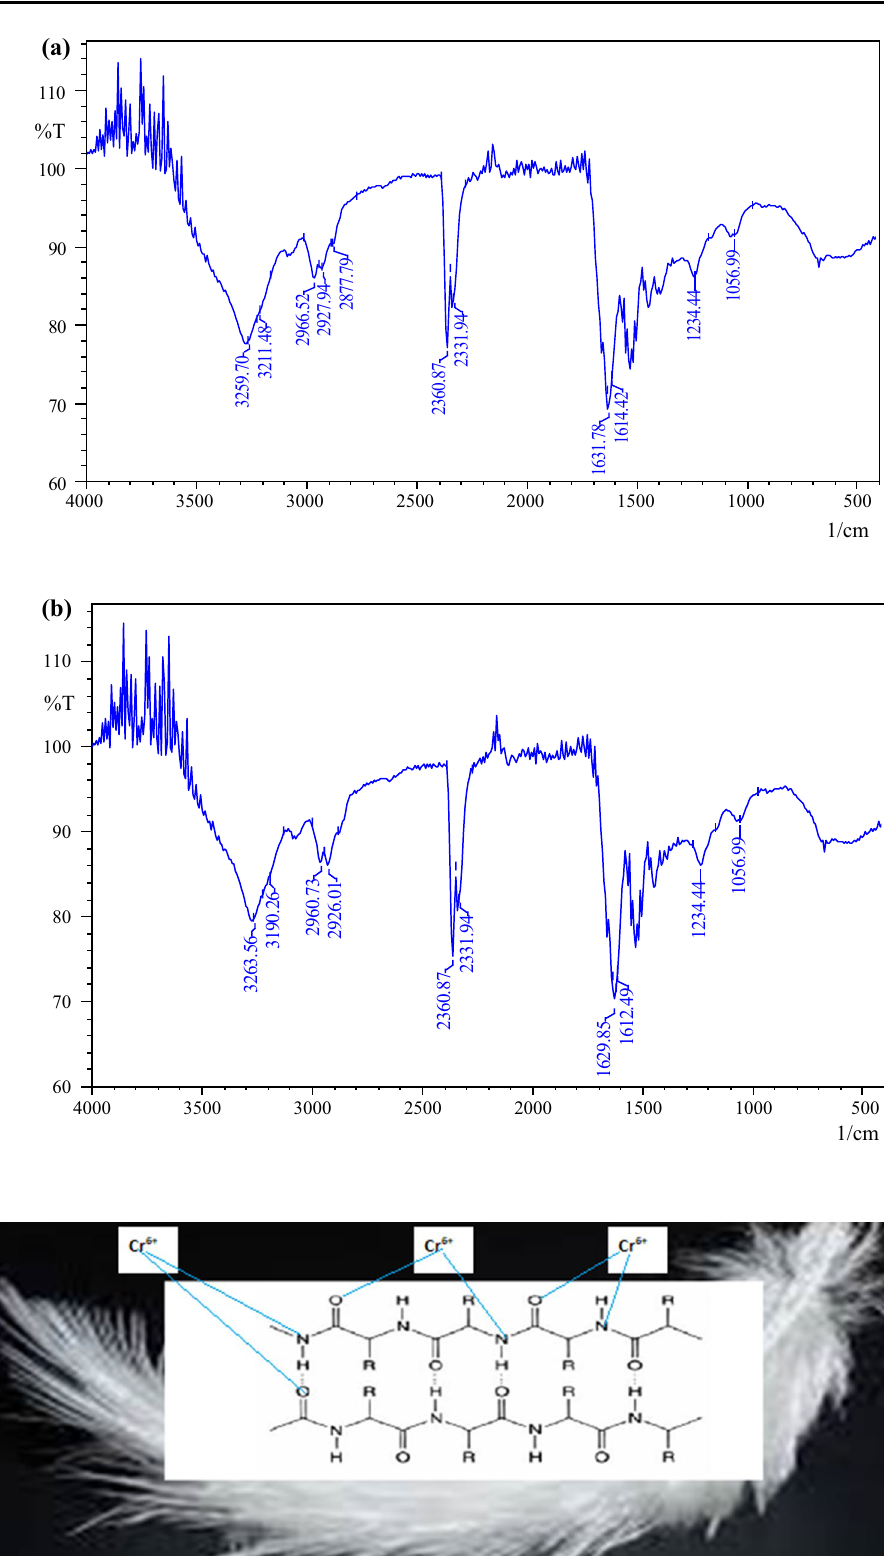
Fig. 3 a Chicken feather before